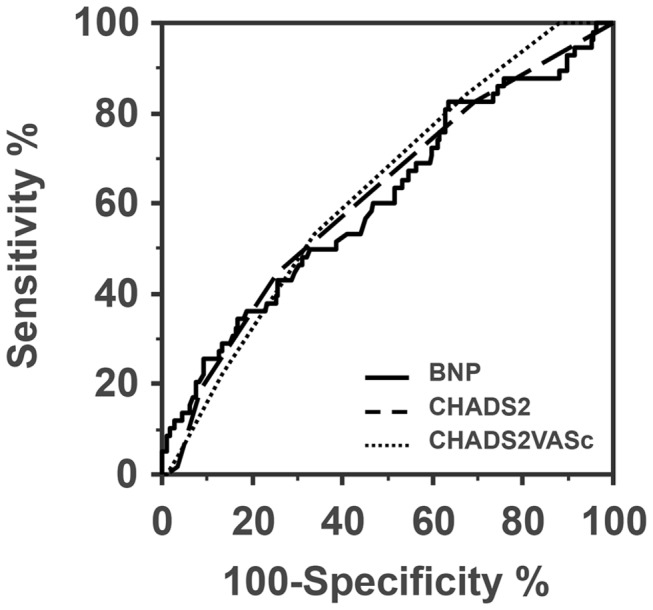
Comparison of ROC curves for prediction of CV events between BNP, CHADS2 and CHADS2-VASc in subjects with AF.